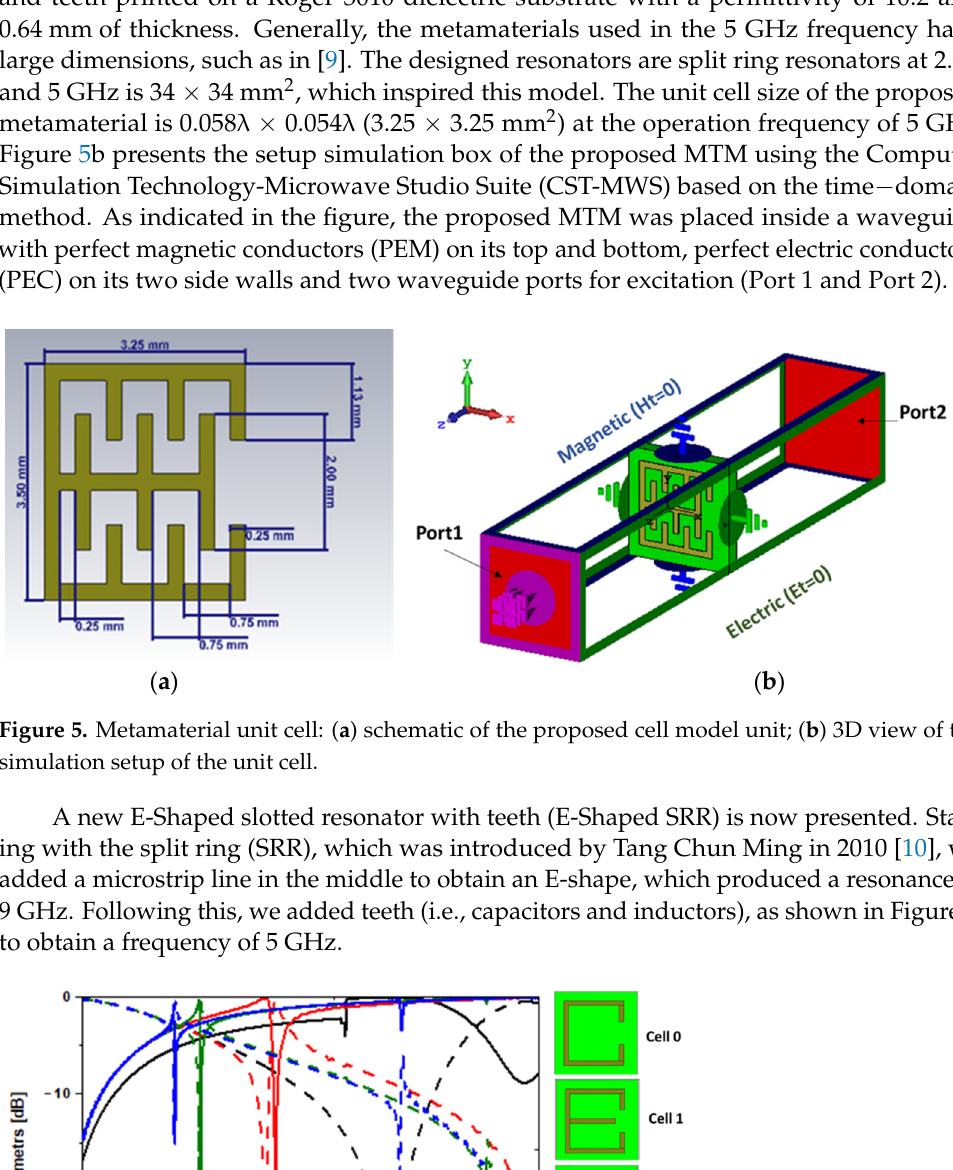
Figure 4. Simulation results of the gain ( a ) versus frequencies ( b ) at 5 GHz.